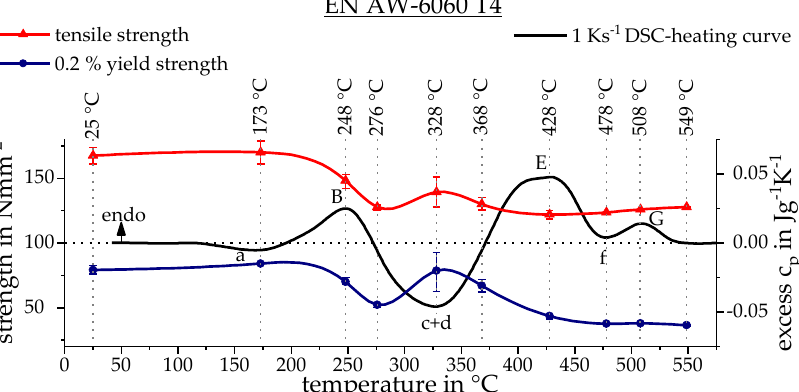
Figure 2. Continuous heating DSC curve of EN AW-6060 T4 at 1 Ks − 1 correlated with the 0.2% yield and tensile strength after heating tensile specimens to di ff erent maximum temperatures followed by overcritical quenching. Experiments described in [21].